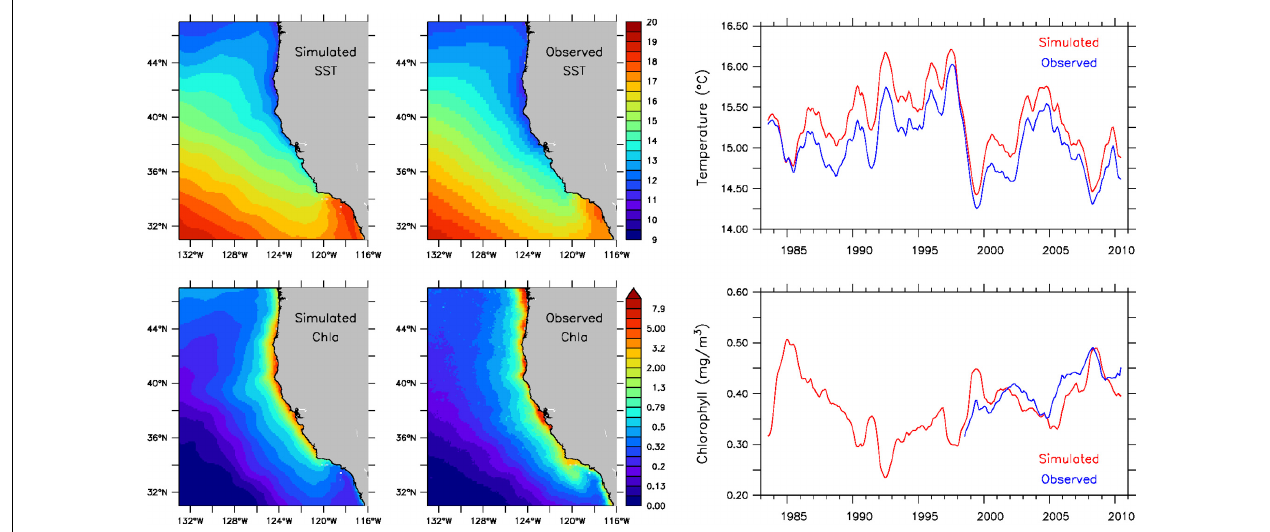
FIGURE 1 | Historical surface temperatures ( ◦ C) (top) and chlorophyll concentrations (mg/m 3 ) (bottom) from the ROMS and NPZ models for 1983–2010. Left panels: simulated and observed annual means. Right panel: monthly simulated (red) and observed (blue) spatial means. Observed temperatures are from NOAA’s OISST AVHRR dataset (https://www.ncdc.noaa.gov/oisst) and chlorophyll concentrations are from NASA’s SeaWiFS dataset (https://oceancolor.gsfc.nasa.gov/data/seawifs).